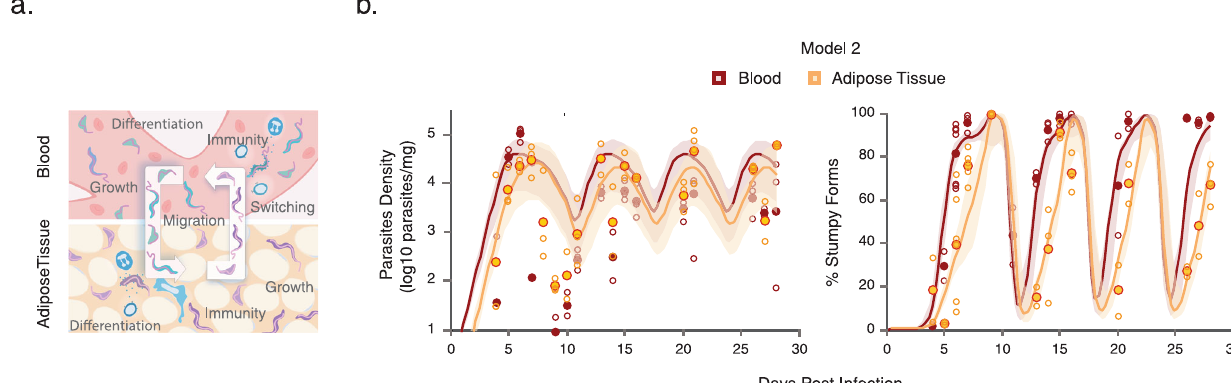
Fig. 2 | Mathematical model for parasite dynamics in blood and gonadal adiposetissue.a Diagram of themathematicalinfectionmodel. Inthis model,two compartments were considered: blood and adipose tissue. In each compartment, parasites mayhave intrinsic growth and differentiationrates. Aconstant migration rate was also considered between the two. The speci fi c immune response was assumedtobetriggeredduetooverallantigenstimulationfrombloodandadipose tissue parasites, after which it grows in response to increasing pathogen density andreacheseachcompartment(MaterialsandMethodsandSupplementaryModel